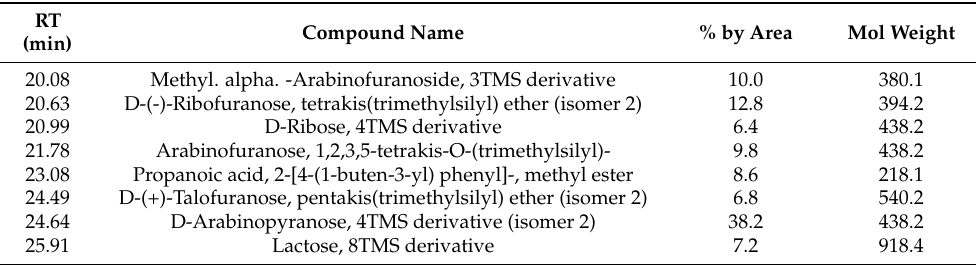
Table 3. Analyses of sugar derivatives compounds in gum Arabic (GA) by GC-MS as a percentage of